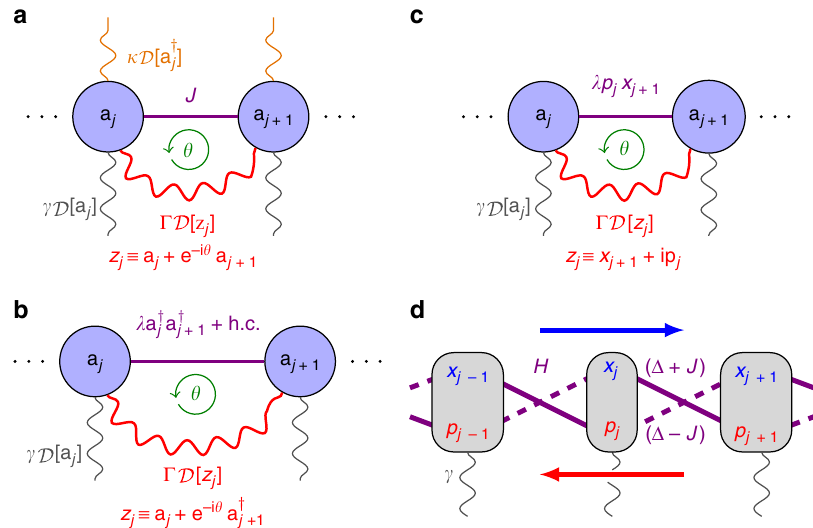
Fig. 5 Some directional ampli fi ers covered by our framework. a Our driven-dissipative cavity chain Eqs. (3), b a phase insensitive ampli fi er with parametric interactions, c a phase sensitive ampli fi er amplifying both x and p quadratures separately, and d a bosonic Kitaev chain 41 , which ampli fi es x and p quadratures in opposite directions. b and c are based on 20,22 . All of these ampli fi ers can be analyzed with our topological